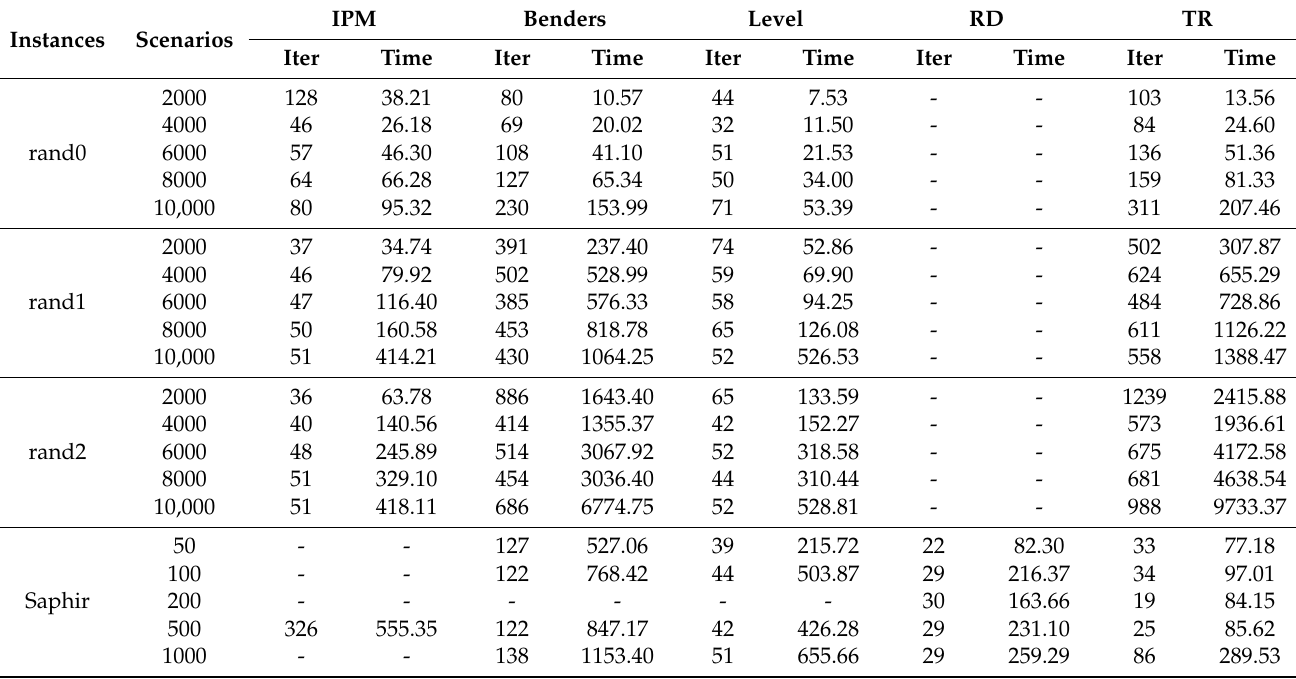
Table A8. Computational results for